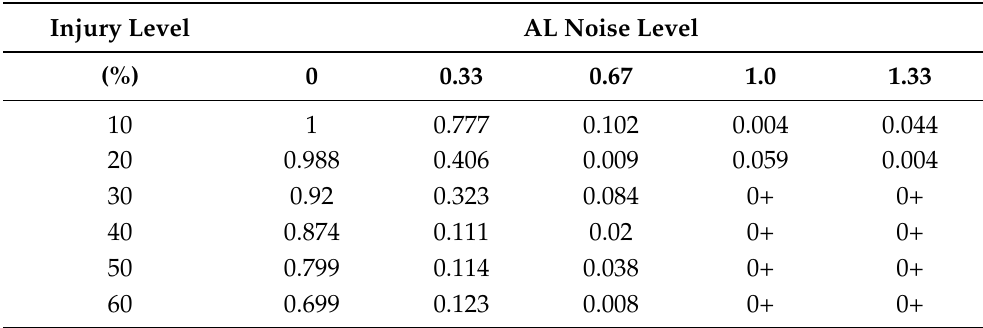
Table A6. P -values for comparison of AL noise’s effects on top-scoring responses vs. average responses, post-training (see Figure 7B vs. D). “0+” indicates p -value < 0.0005. N = 31 to 40 (mean =